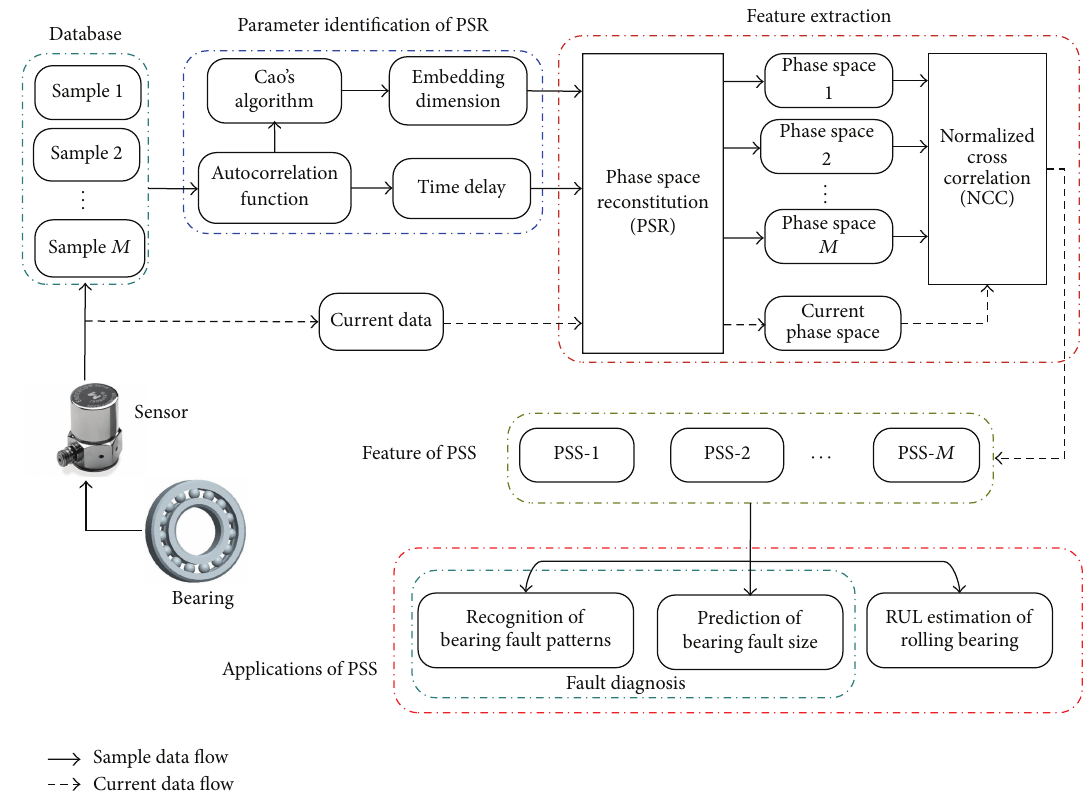
Figure 1: Framework of the proposed method.